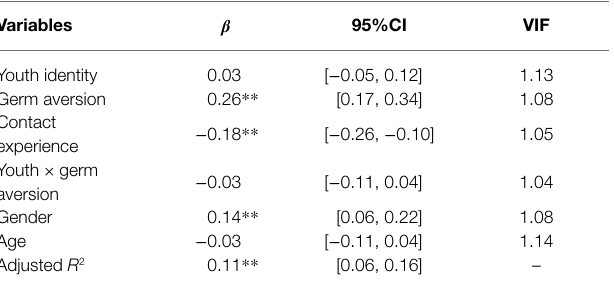
TABLE 3 | Multiple regression analysis including an interaction between youth identity and germ aversion.